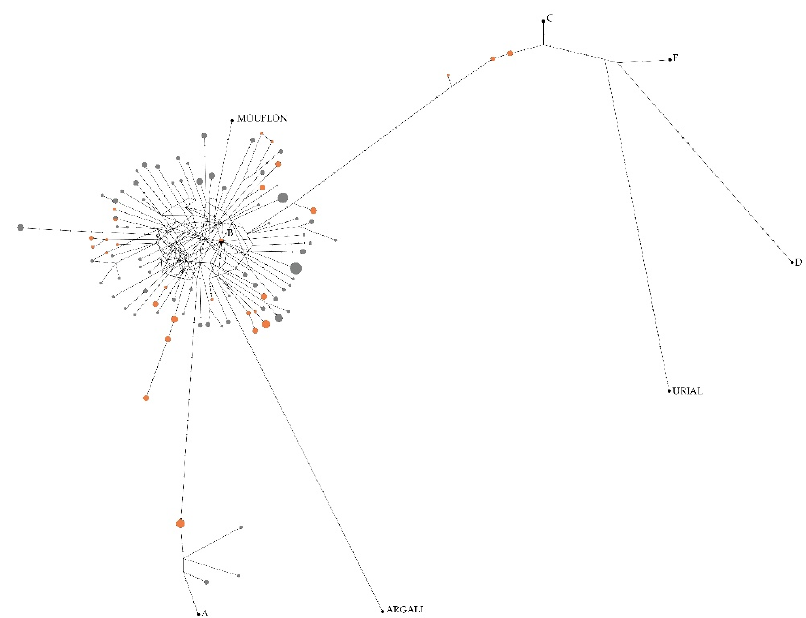
Figure 2. Connections between sample CR haplotypes and reference CR haplogroups by median- joining network. Legend: Tsigai (gray), Cikta (orange), different black colored spots with denomina- tion are reference samples (A-HM236174, B-HM236176, C-HM236178, D-HM236180, E-HM236182 [17]; O. musimon Mouflon HM236184, O. ammon Argali HM236188, O. vignei Urial HM236186 [39]). The size of the circles is in proportion to the number of individuals observed per haplotype, and the lines crossed in the sections connecting the haplotypes indicate the number of mutations between